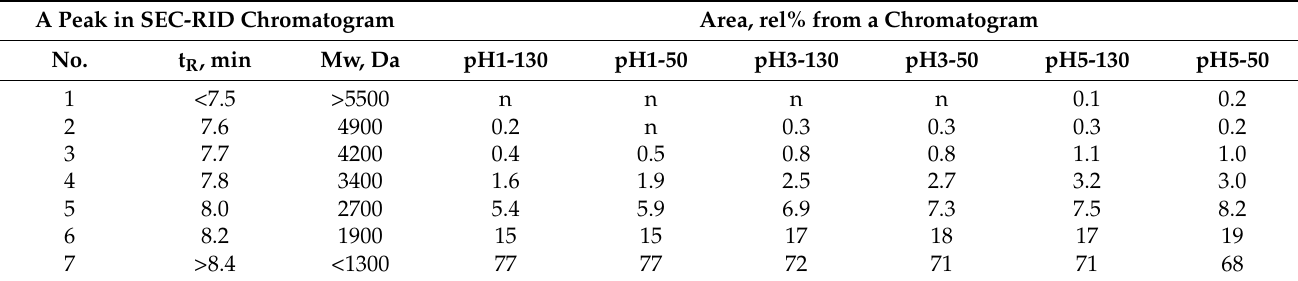
Table 4. Relative abundance of high molecular weight compounds in the samples. A Peak in SEC-RID Chromatogram Area, rel% from a